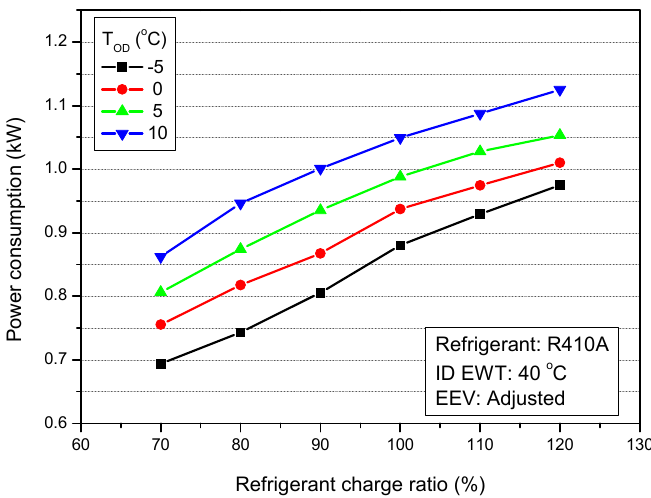
Figure 17. Variation of power consumption with refrigerant charge ratio and T OD .